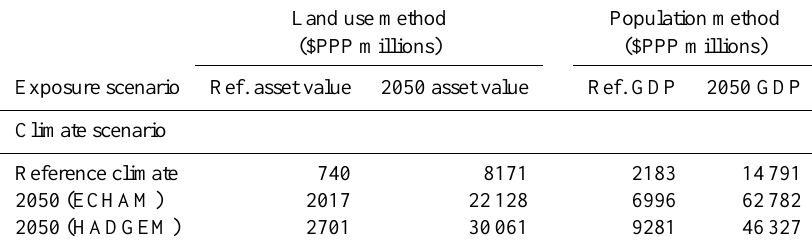
Fig. 6. Estimates of the moment of flooding during the summer of 2004 over Bangladesh and surroundings. Left: Dartmouth Flood Observa- tory observations, Right: GLOFRIS modelled estimates. The color scale indicates the first moment that any flooding occurs (i.e. water level > 0m). Table 2. Expected annual damage (land use and population method approach) for the Bangladesh case study for the reference scenario and for the future scenarios (2050) with hazard change only (ECHAM, HADGEM), exposure change only, and hazard and exposure change